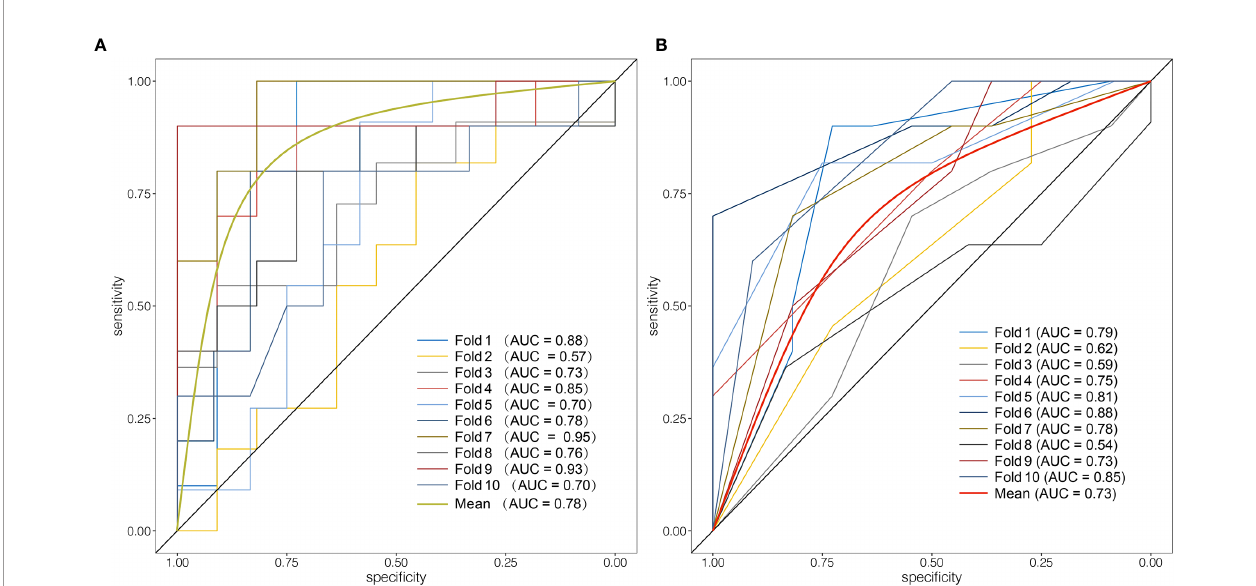
FIGURE 5 | Evaluation of the diagnostic performance of the Rad-score and the radiological model. ( A) Receiver operating curves of 10-fold cross validation of the Rad-score. The Rad-score achieved average AUC of 0.78. ( B) Receiver operating curves of 10-fold cross validation of the radiological model. The average AUC of the radiological model was 0.73.